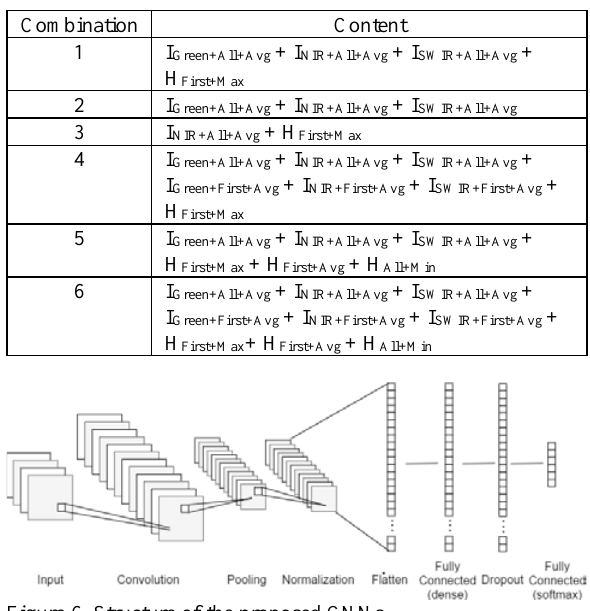
Table 2. Contents of input combination.